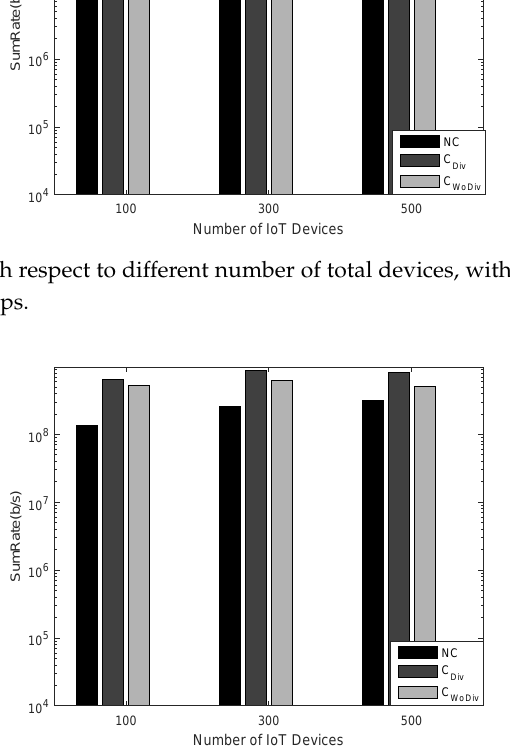
Figure 14. Sum-rate with respect to different number of total devices, with 10 relays and minimum device data rate of 125 kbps.